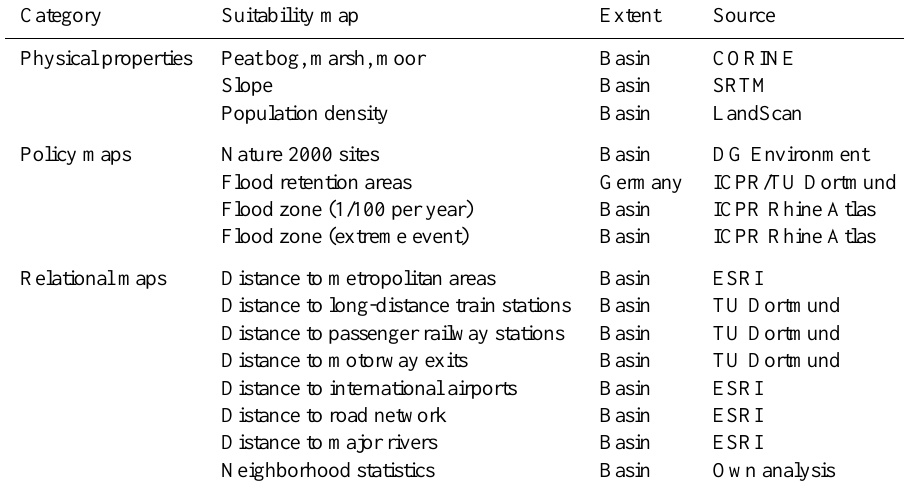
Table 1. Suitability maps used for the “Land Use